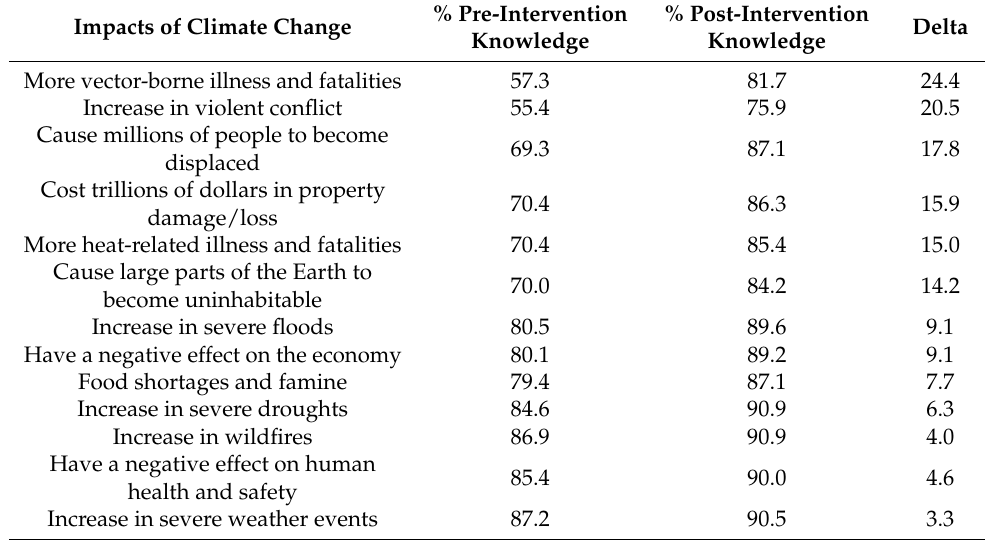
Table 5. Comparison of Pre and Post-intervention Knowledge of Climate Change